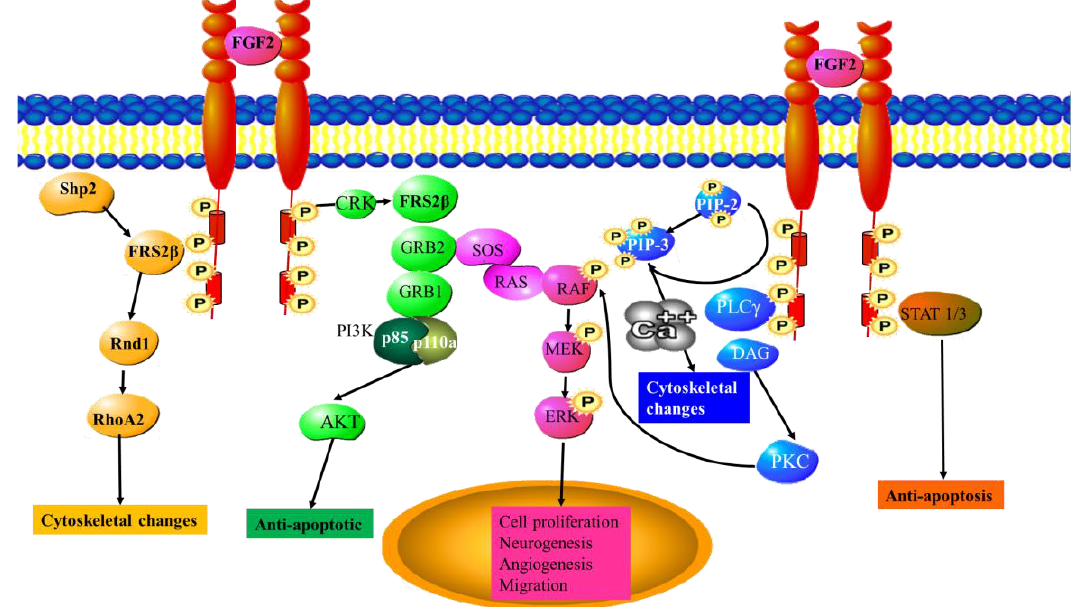
Figure 2. FGF-2 signaling pathways. The binding of FGF-2 to the FGF receptor FGF-R. The FGF-2 signaling pathway activates the Ras/ERK pathway, which leads to the activation of pro-angiogenic and pro-neurogenic genes. ERK — extracellular signal-regulated kinase, FRS2 β— fibroblast growth factor (FGF) receptor substrate 2, GRB1/2 — Growth factor receptor-bound protein 1/2, MEK — Mitogen-activated protein kinase, PI3K — Phosphoinositide 3-kinase, Rnd1 — Rho-related GTP-binding protein, Shp2 — Src homology region 2, SOS — Son of Sevenless.